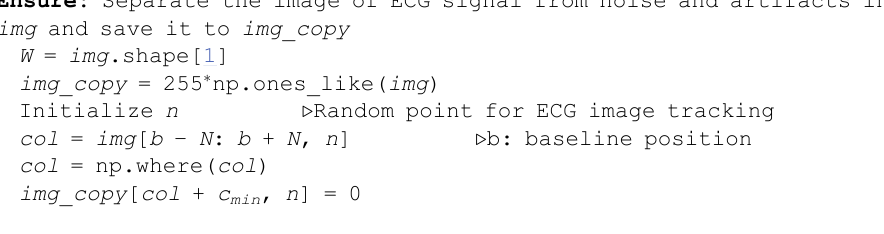
Algorithm 1 Noise and artifacts removal algorithm